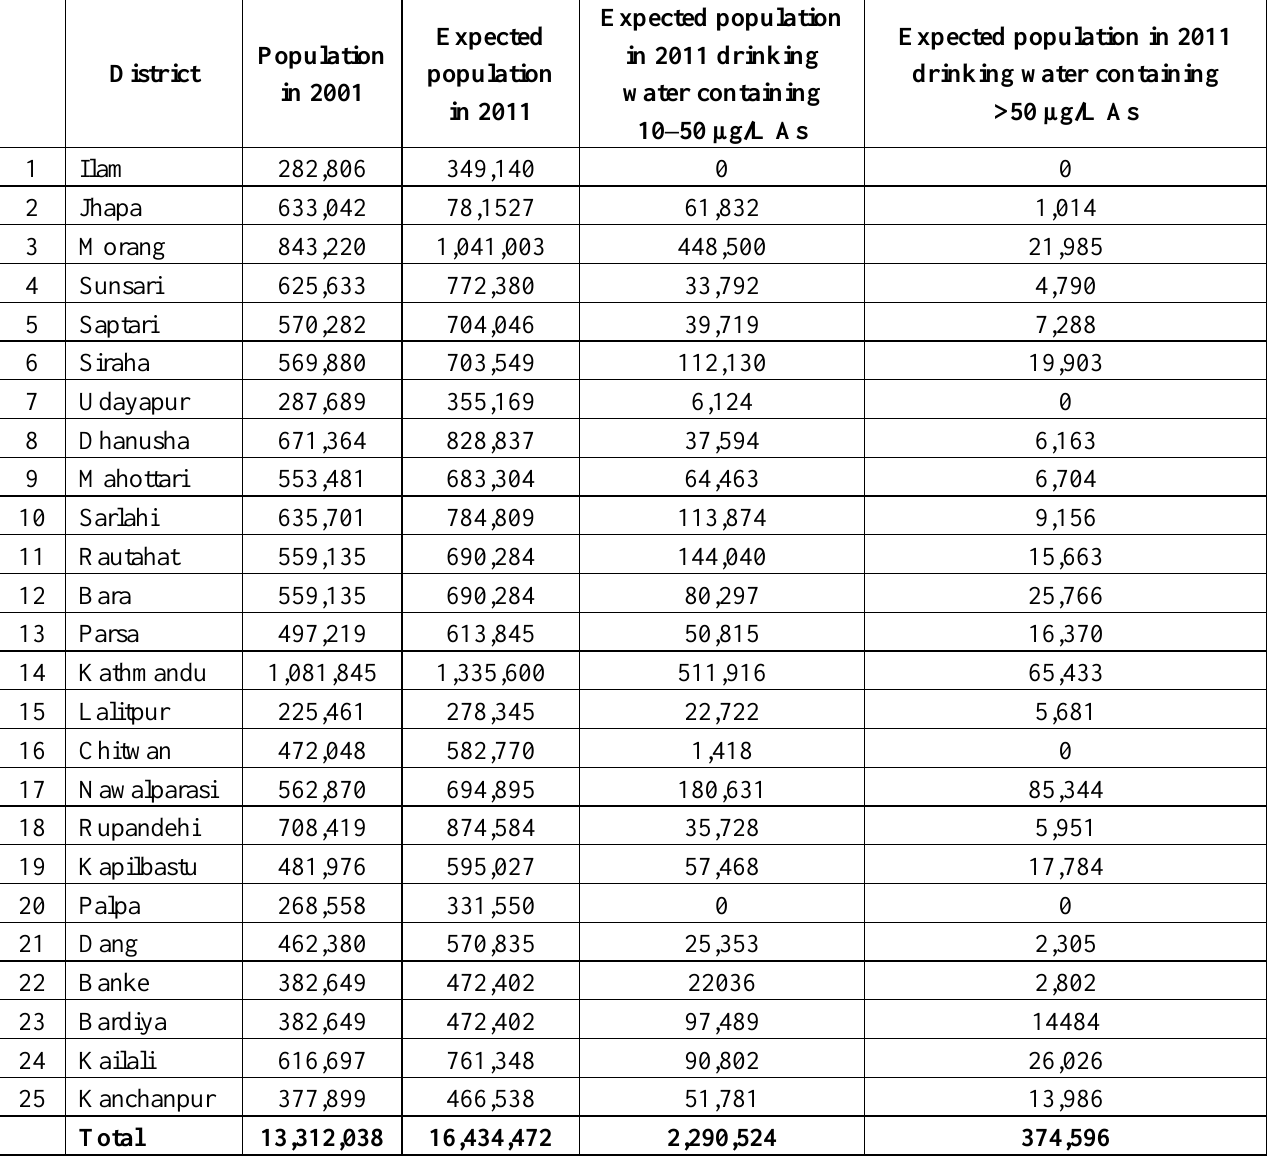
Table 3. District wise expected number of population drinking arsenic contaminated water containing 10–50 µg/L As and >50 µg/L